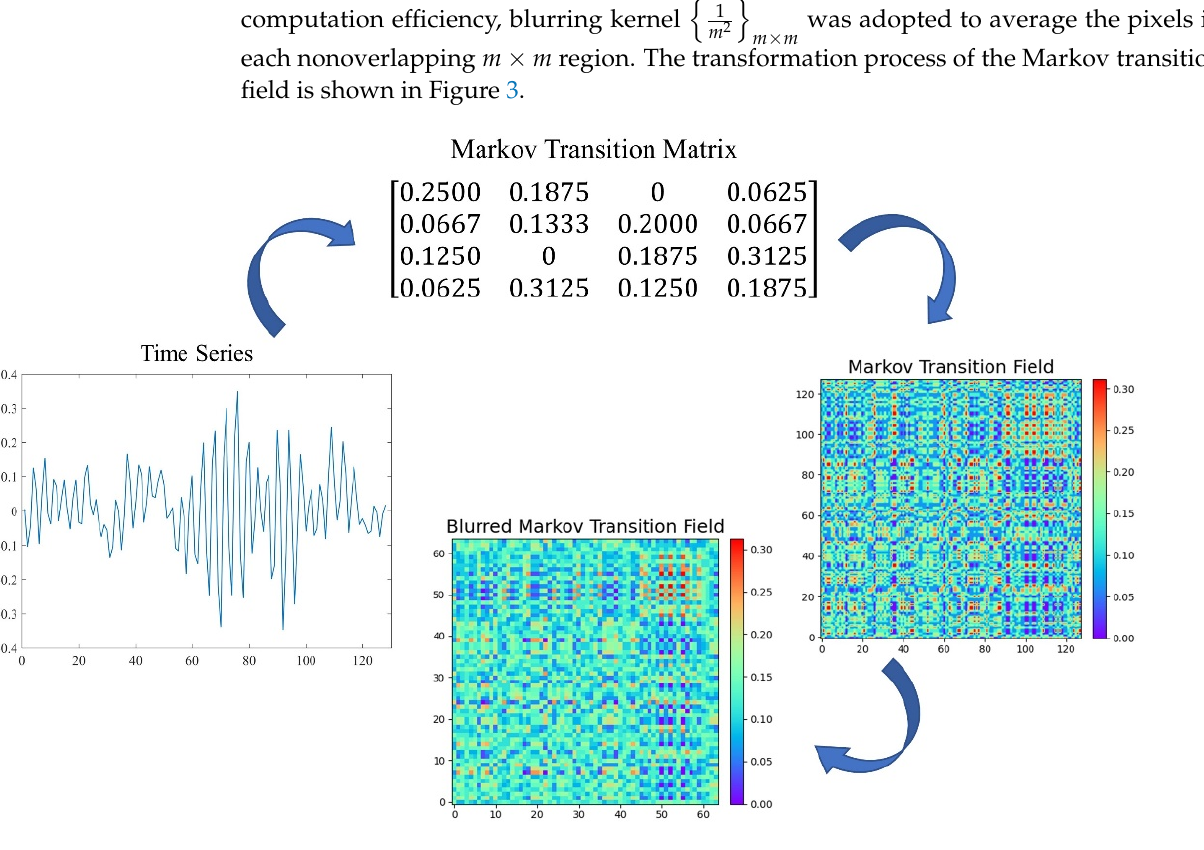
Figure 4. Architecture of the proposed MTF-ResNet model.